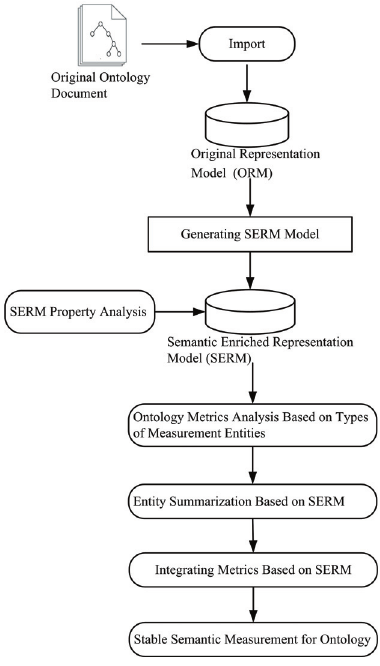
Fig. 1. The overview of